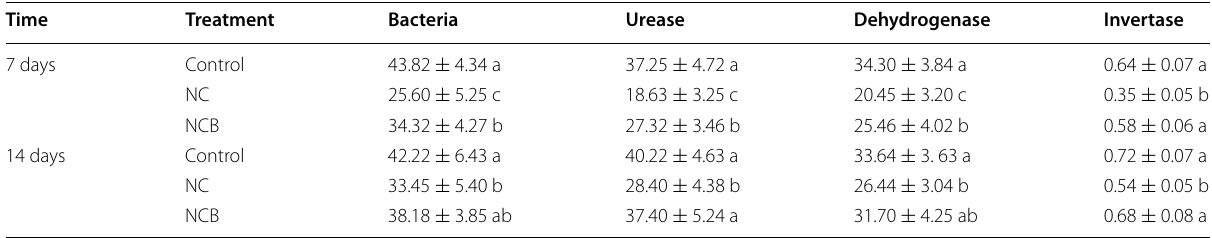
Table 2 Bacterial population and enzymatic activity in the soil treated with chlorothalonil or/and strain BJ1